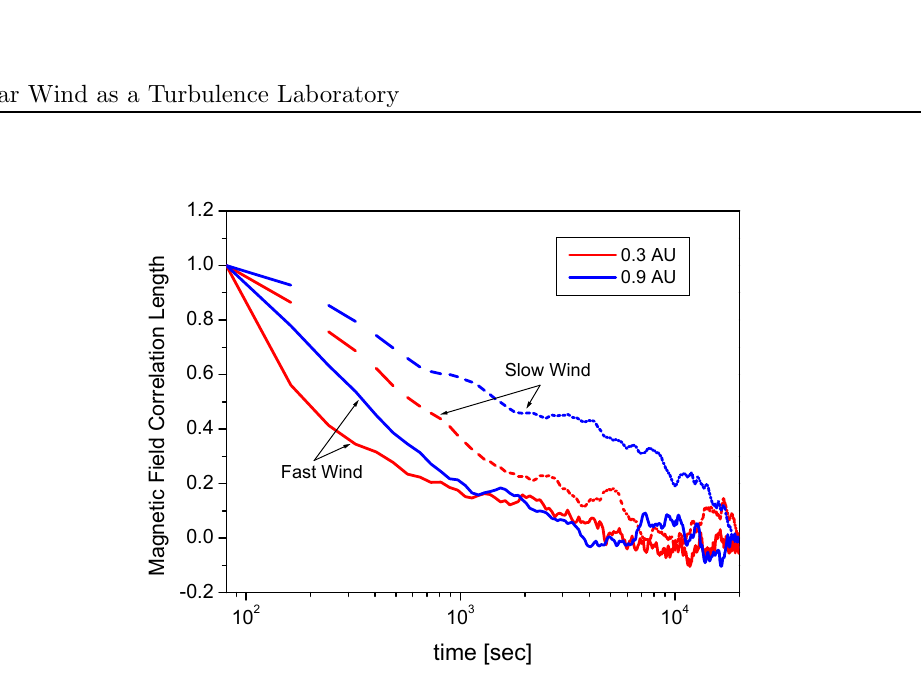
Figure 32: Correlation function just for the 𝑍 component of interplanetary magnetic field as observed by Helios 2 during its primary mission to the Sun. The blue color refers to data recorded at 0.9 AU while the red color refers to 0.3 AU. Solid lines refer to fast wind, dashed lines refer to slow